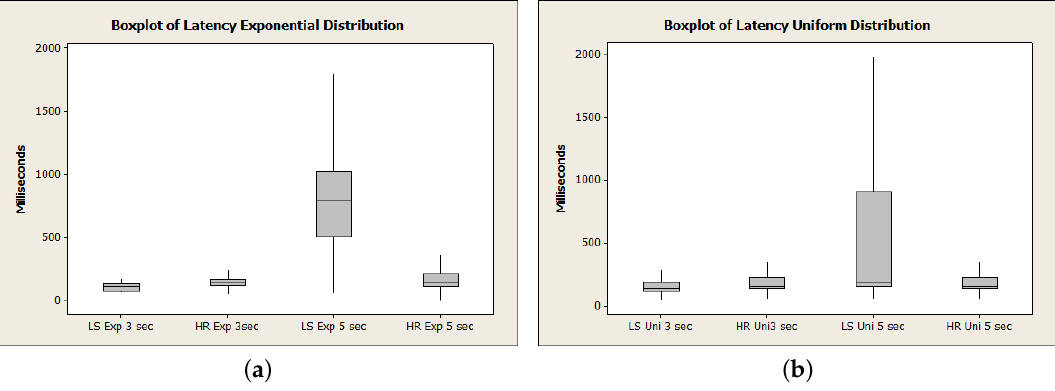
Figure 9. Total latency. ( a ) Latency time distribution: exponential, ( b ) Latency time distribution: uniform.